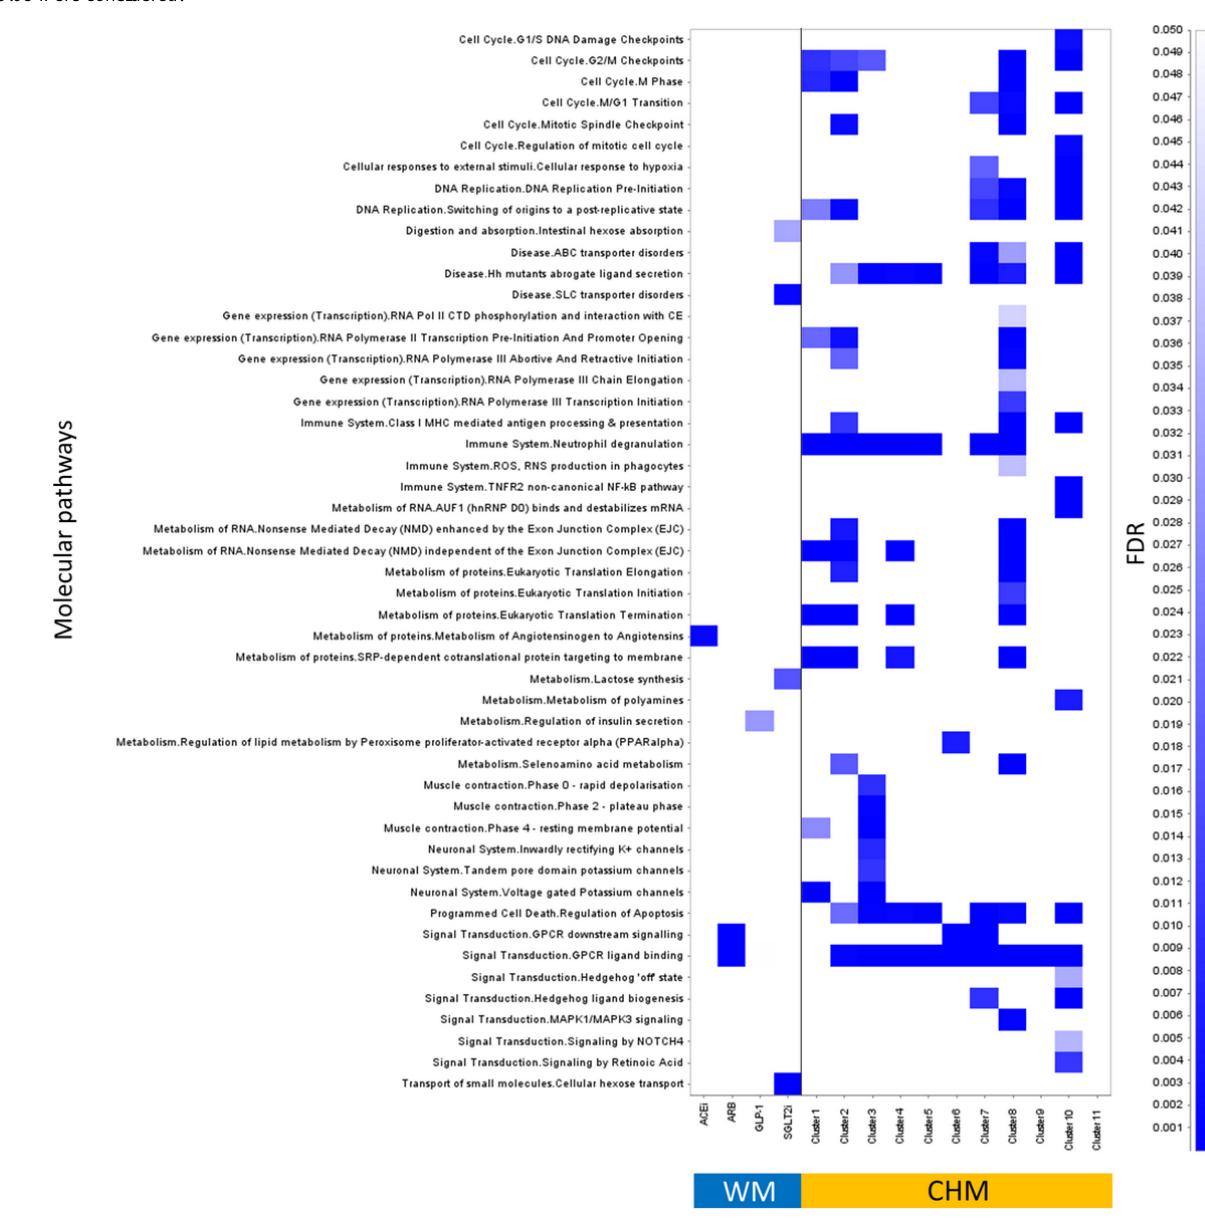
Figure 7. Summary of biomedical pathways covered by clusters of Chinese herbal medicine (CHM) and Western medicine (WM). Pathway overrepresentation analysis and classification was performed by assessing the online Reactome database, and only pathways with a false discovery rate ≤ 0.05 were